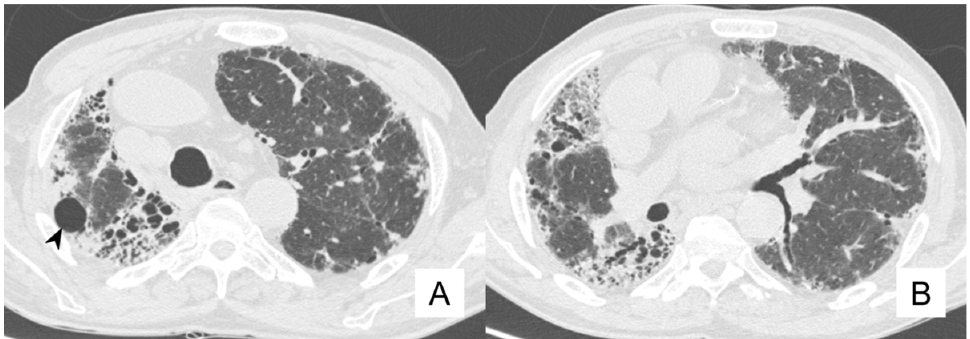
Figure 13. An 80-year-old man with values of SpO 2 , Forced Vital Capacity (FVC) and Forced Expiratory Volume in one second (FEV1) equal to 94%, 57% and 56%, respectively (at first CT scan). A typical IPF pattern was clearly depicted (A,B).